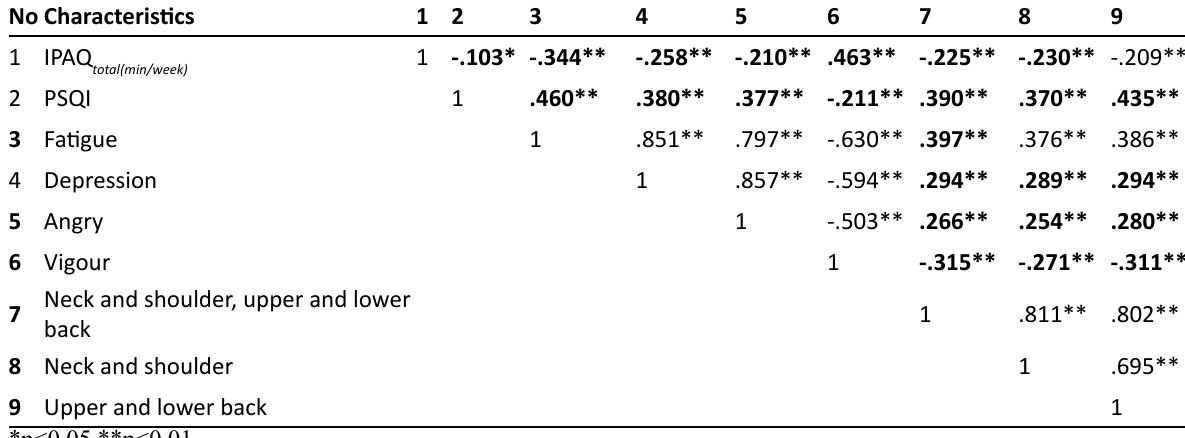
Table 2. Association among IPAQ, PSQI and Moods and MSP (Pearson Correlation Coefficient) No Characteristics